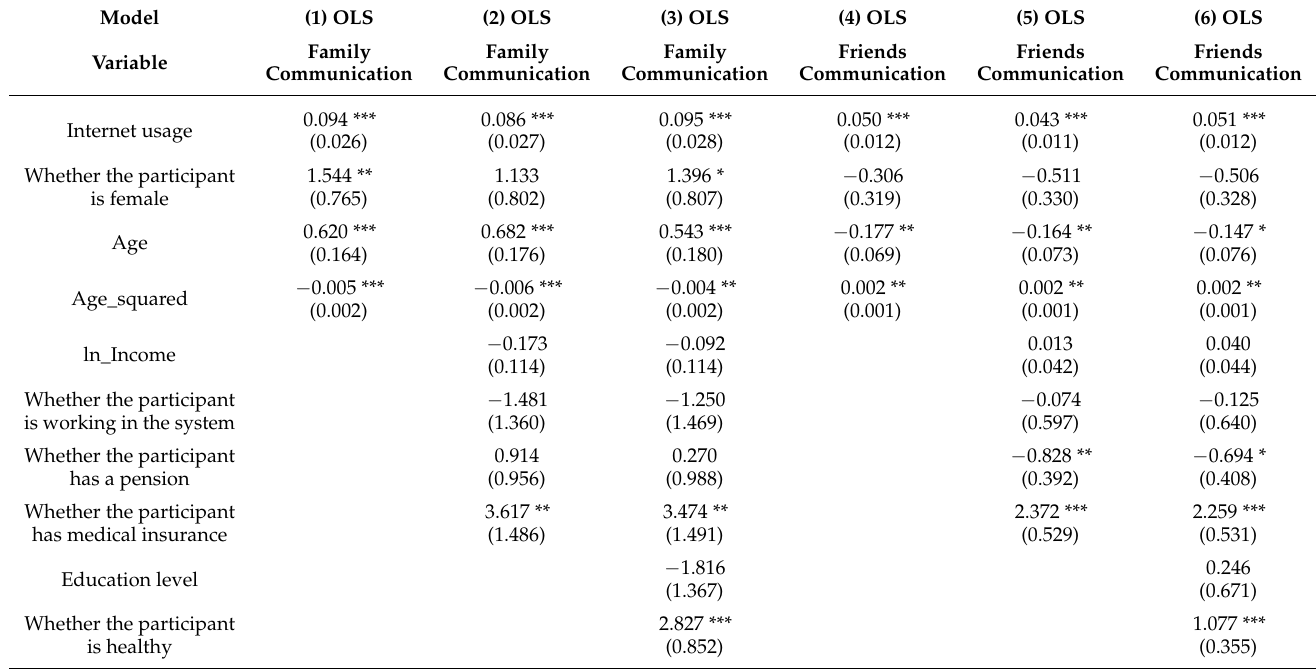
Table 2. Benchmark